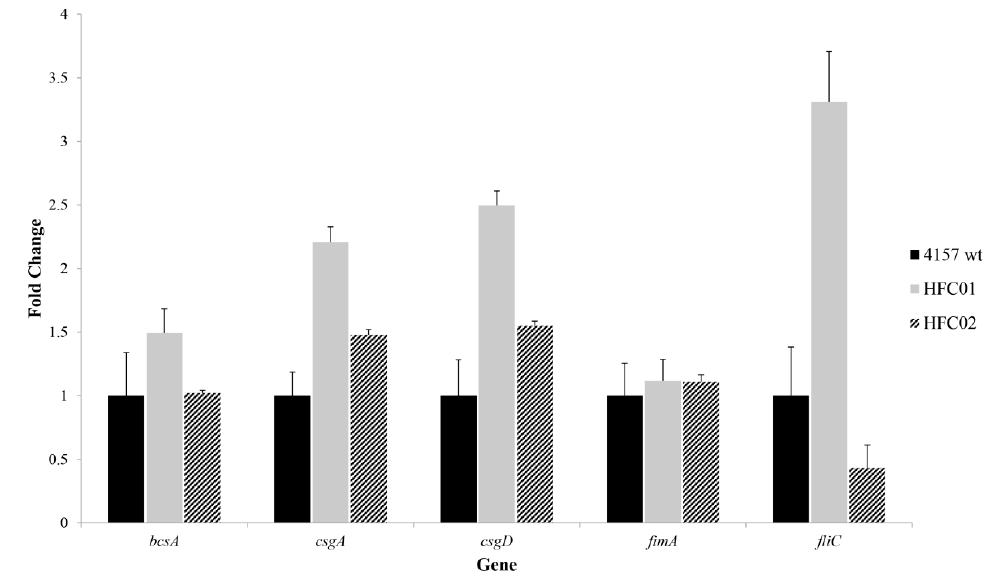
Figure 6. Transcription analysis of biofilm formation related genes ( bcsA , csgD , csgA , fimA and fliC ) by quantitative real-time PCR (qRT-PCR), in ONT:H25 (4157 wild type), HFC01 and HFC02 strains. C t values were normalized by rpoA transcription. Error bars represent the standard deviation from triplicates.